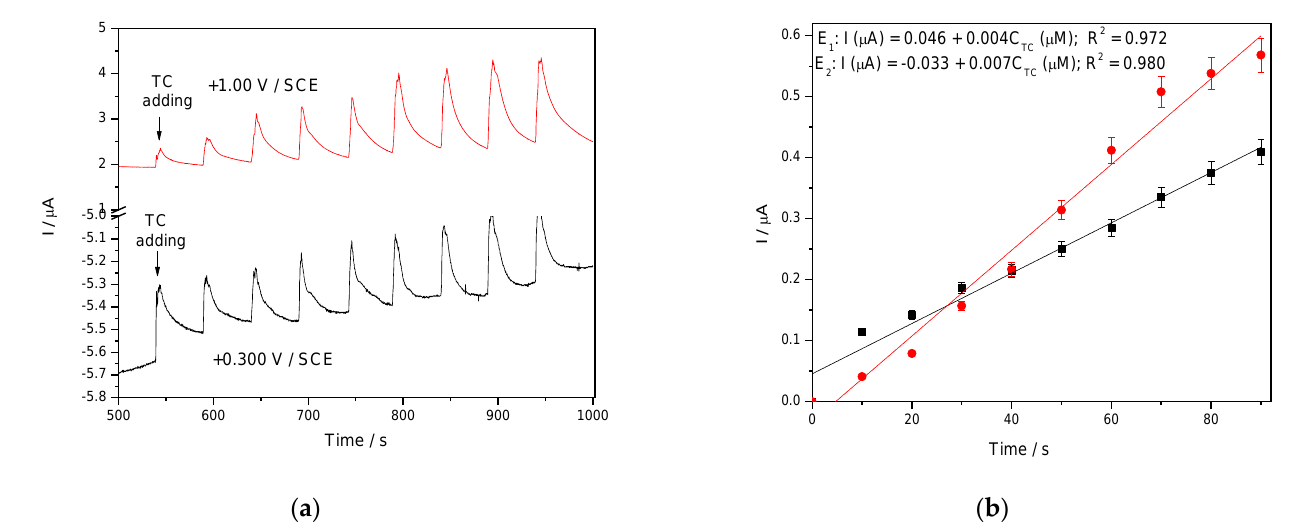
Figure 15. ( a ) MPAs recorded at Ag/GO/BDD in 0.1 M Na 2 SO 4 supporting electrolyte in the presence of various TC concentrations: 10–90 µ M TC at two applied potential levels, +0.300 V/SCE and +1.00 V/SCE. ( b ) The calibration plots of the currents recorded at recorded at E 1 = +0.300 V/SCE and E 2 = +1.00 V/SCE versus TC concentrations. Table 5. Electroanalytical performance of Ag/GO/BDD electrode for TC detection in aqueous solution. Supporting Electrolyte